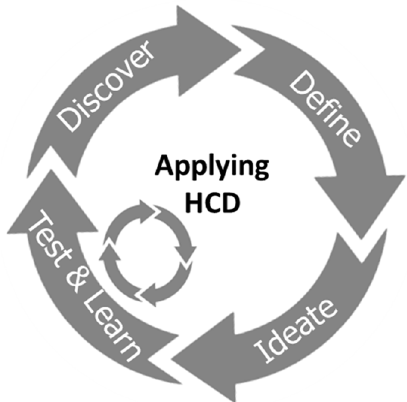
Figure 2. Diagram illustrating the different steps of a Human Centred Design study. After defining the area of innovation, the target end users and the context of use are considered to ideate possible solutions for the unmet need that is being addressed. The proposed solutions are tested by potential end users and their feedback is incorporated into a refined design. Multiple iterations of this process lead to the development of the final